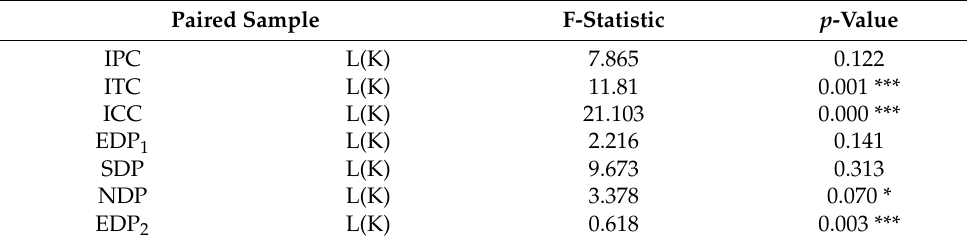
Table 9. Results of the Granger causality